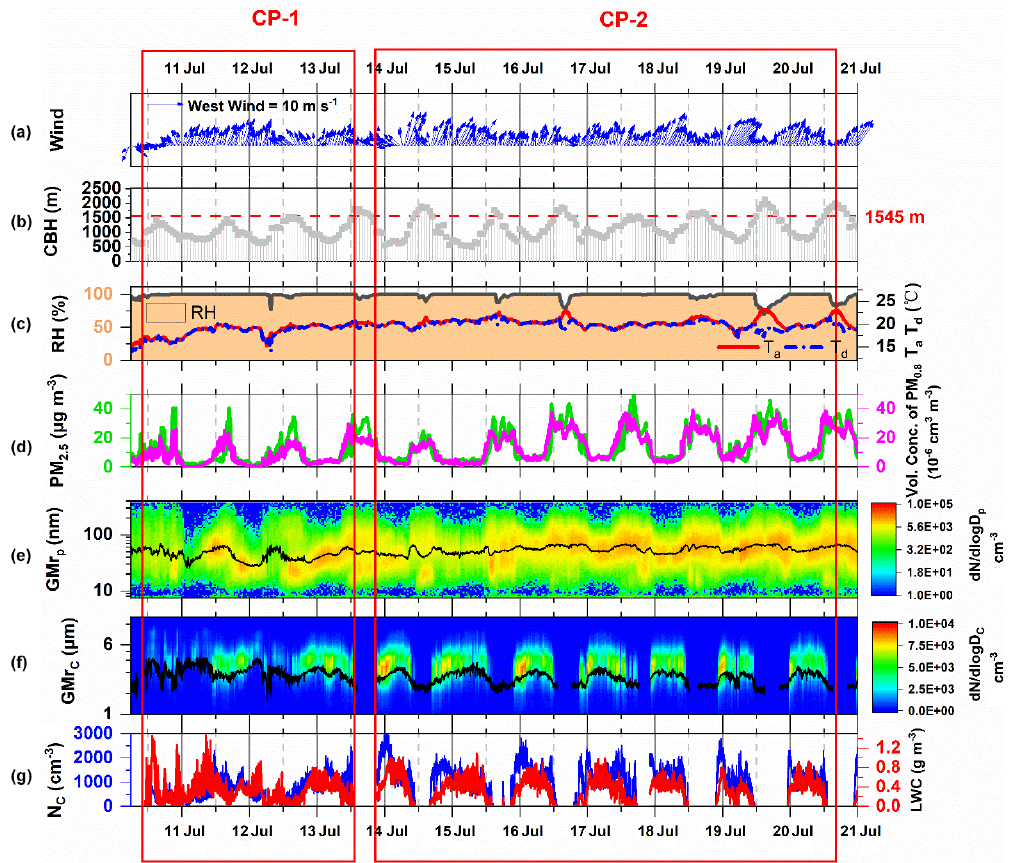
Figure 2. The monitoring information of CP-1 and CP-2. Including (a) wind speed (WS, ms − 1 ) and wind direction (WD); (b) cloud base height (CBH, m); (c) relative humidity (RH, %), ambient temperature ( T a , ◦ C), and dew point temperature ( T d , ◦ C); (d) PM 2 . 5 mass concentrations (µgm − 3 ) and volume concentration of PM 0 . 8 (10 − 6 cm 3 cm − 3 ); (e) size distribution of particles (13.6–763.5nm) and corre- sponding geometric mean radius (GMr P ); (f) size distribution of cloud droplets (2–50µm) and corresponding geometric mean radius (GMr C ); and (g) N C and LWC of cloud